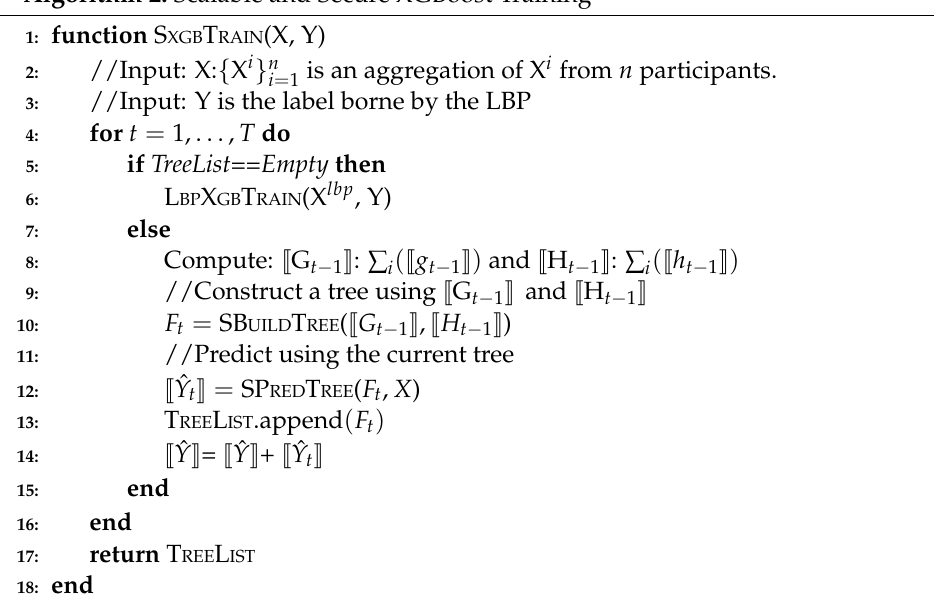
Algorithm 2: Scalable and Secure XGBoost